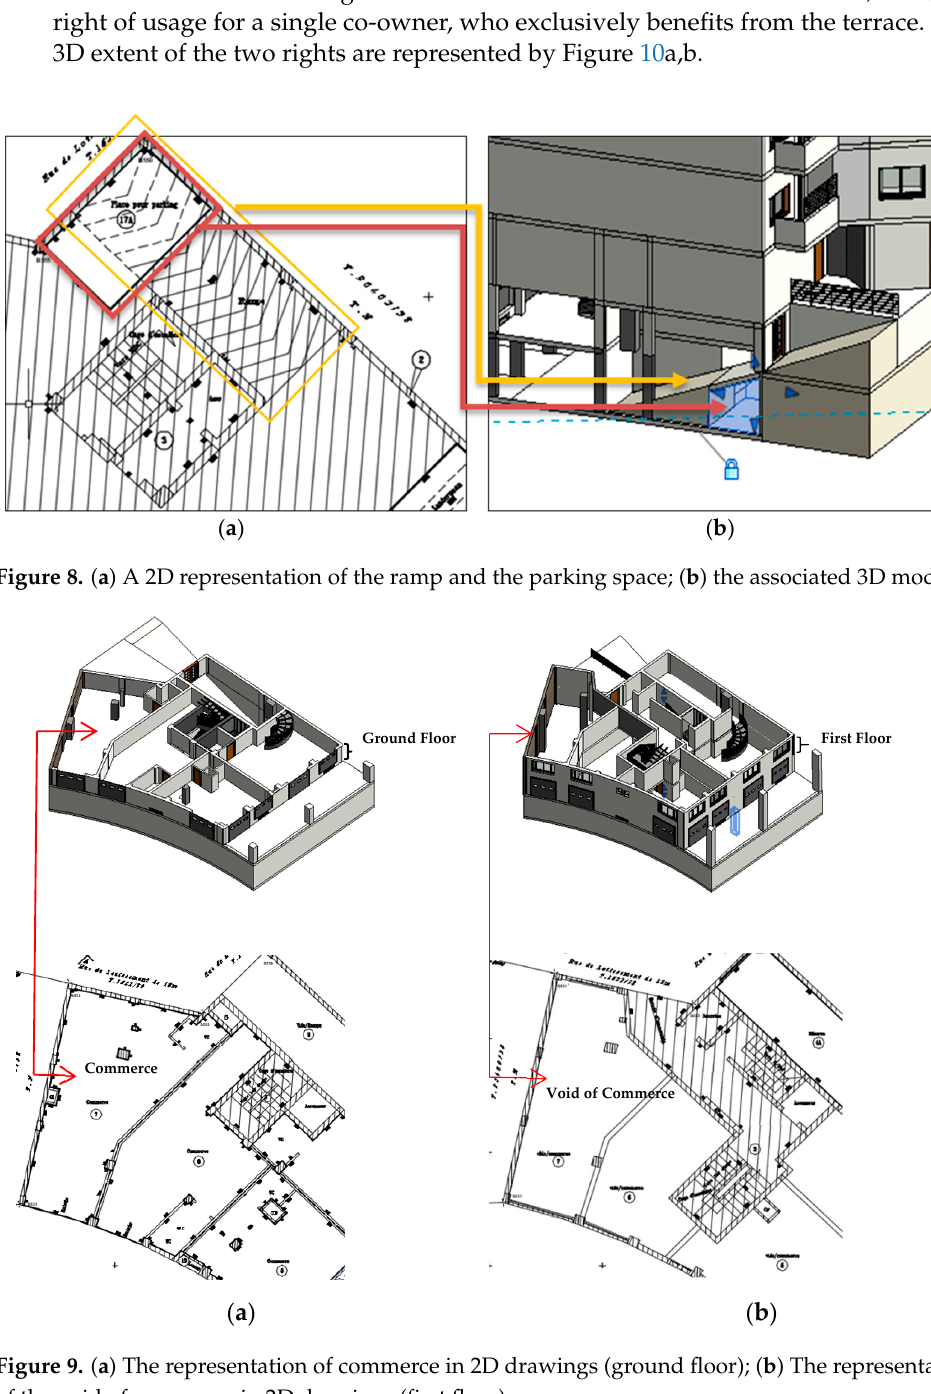
modeling process: 1. tation associated to this situation shows the space and ramp in the same level with two different symbols (Figure 8a). With such a representation, the interpretation is difficult. An on-site visit was necessary to understand the situation represented by the 3D model in Figure 8b.